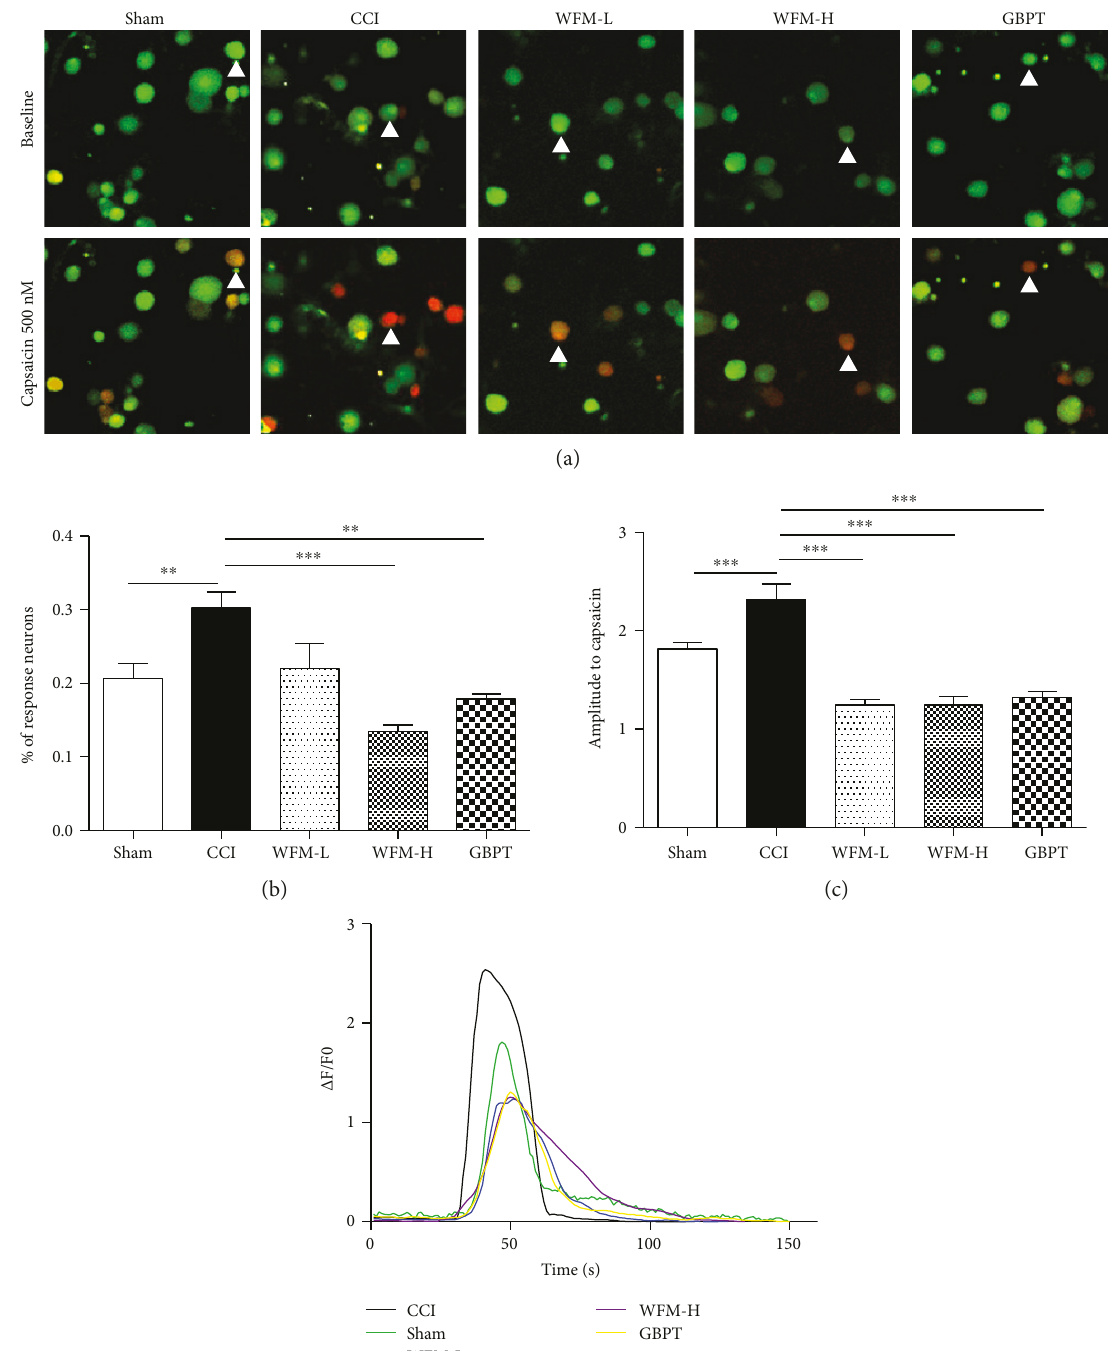
Figure 6: WFM attenuated capsaicin-induced response in CCI-treated sensory neurons. (a) Representative calcium images in cultured DRG neurons from CCI contralateral and ipsilateral. WFM and GBPT could signi fi cantly inhibit the responses of DRG neurons from CCI ipsilateral to 500nM capsaicin. (b) The percentage of reactive neurons to 500nM capsaicin stimulus. The percentage of DRG neuron response to 500 nM capsaicin stimulus was signi fi cantly higher in the ipsilateral (CCI) than in the contralateral (control). WFM and GBPT could signi fi cantly reduce the response percentage of DRG neurons to the same concentration of capsaicin stimulus. (c) The amplitude of the response neurons to 500 nM capsaicin stimulus. The amplitude of DRG neurons response to 500nM capsaicin stimulus was signi fi cantly larger in the ipsilateral (CCI) than in the contralateral (control). Both WFM (high dose and low dose) and GBPT could e ff ectively inhibit capsaicin-induced response. (d) Calcium imaging response curves of DRG neurons to di ff erent stimulus. White arrows indicate these active neurons. ∗ p < 0 05 , ∗∗ p < 0 01 , ∗∗∗ p < 0 001